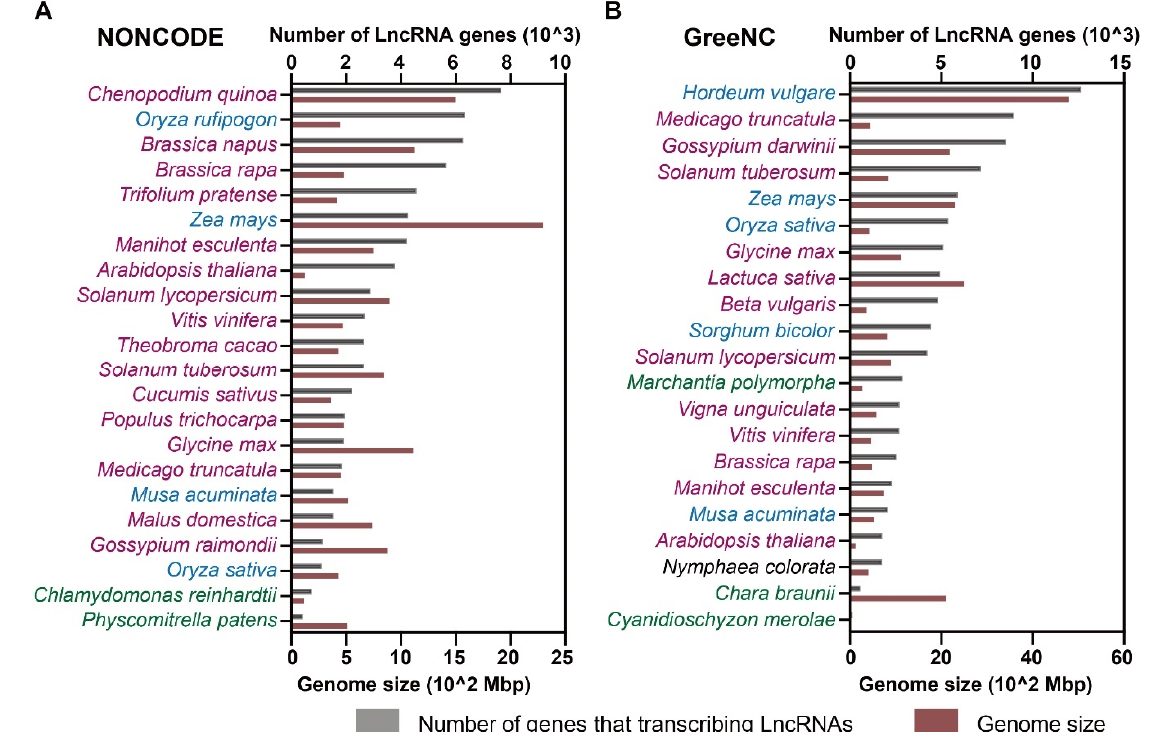
Figure 2. Number of genes transcribing lncRNAs and the genome size of plants. ( A ) LncRNA information extracted from NONCODE. ( B ) LncRNA information extracted from GreeNC. The red color of characters represents plant species in Eudicotyledoneae; blue color represents plant species in Monocotyledoneae; black means plant species in basal Angiosperms; and green color means plant species in cladogram of non-flowering plants. The numbers of genes that transcribe lncRNAs are represented by gray boxes, and the genome sizes are represented by red